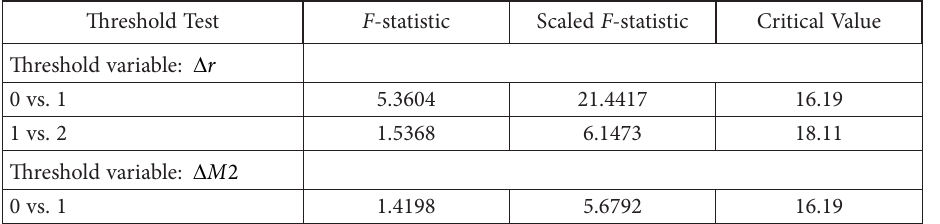
Table 7. Testing for threshold